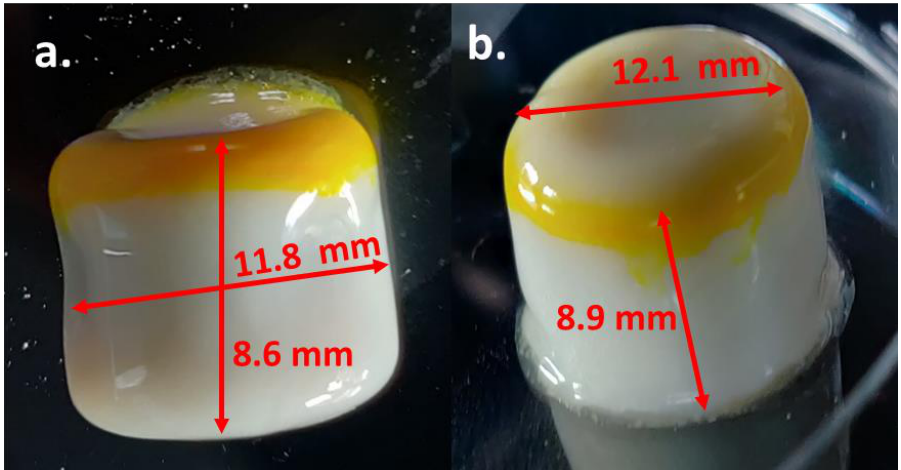
Figure 13. Post-dissolution images of prints containing SNEDDS ( a ) print with 0.4 mm wall thickness and ( b ) print with 1 mm wall thickness.